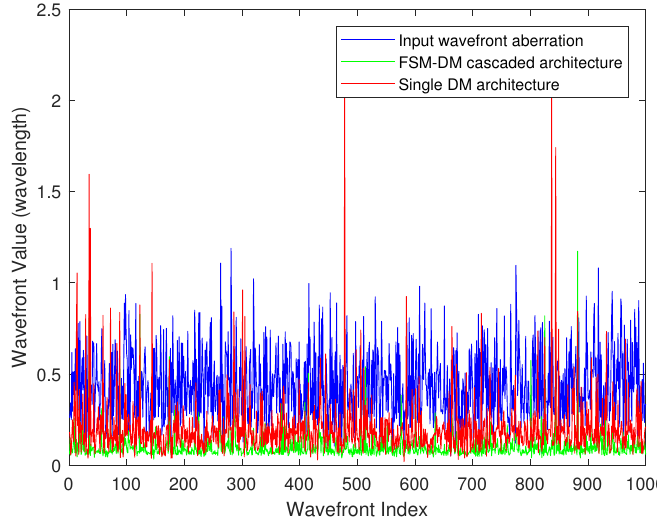
Figure 13. Compensation results of the wavefront RMS value by FSM-DM cascaded architecture and single DM